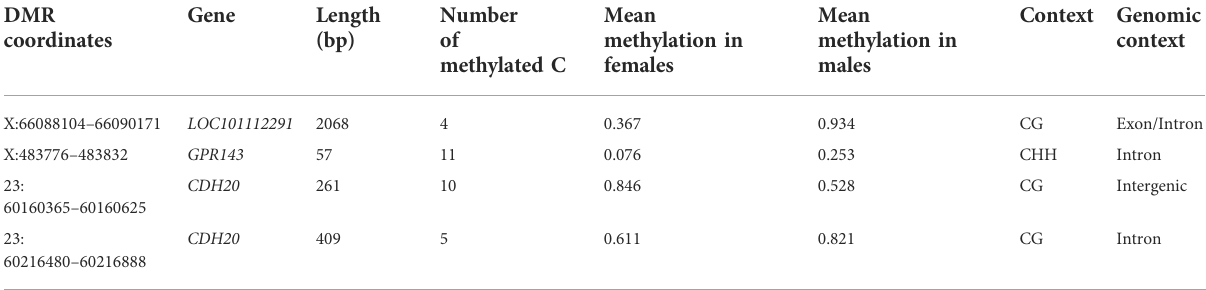
DMR, differential methylated regions; bp, base